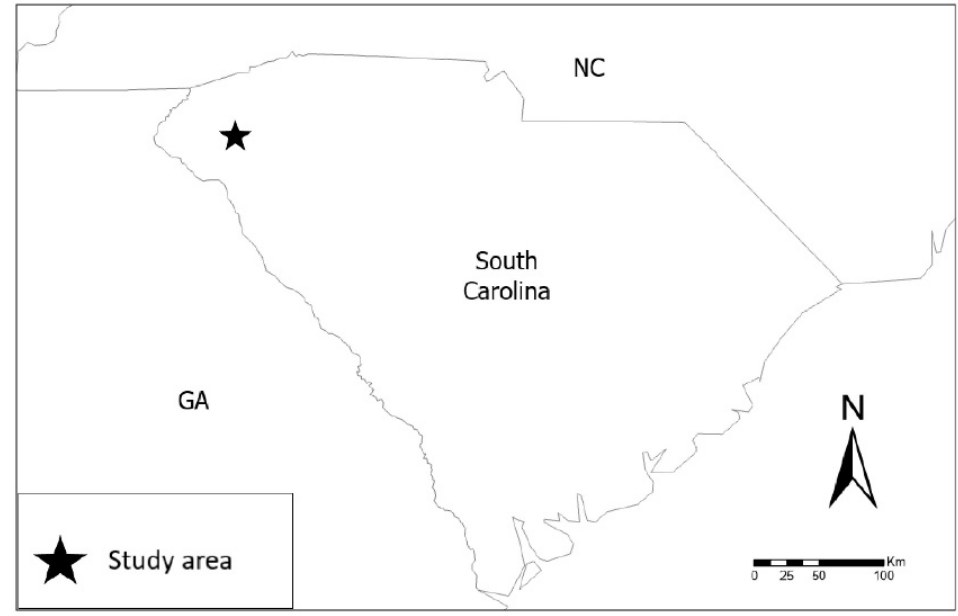
Figure 1. Location of the study areas in Pickens County, South Carolina (SC), USA.